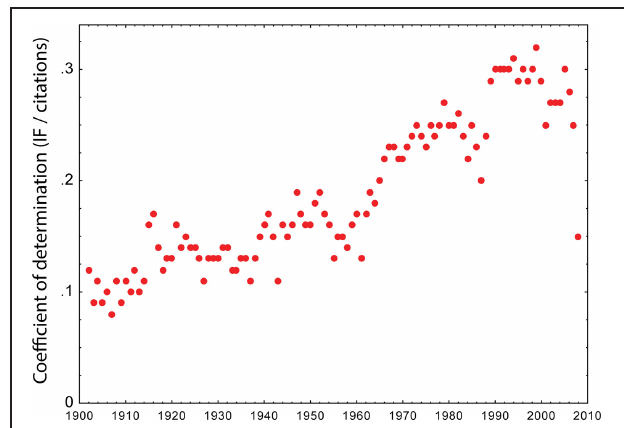
FIGURE 3 | Trends in predicting citations from journal rank. The coefficient of determination (R 2 ) between journal rank (as measured by IF) and the citations accruing over 2 years after publications is plotted as a function of publication year in a sample of almost 30 million publications. Lozano et al. (2012) make the case that one can explain the trends in the predictive value of journal rank by the publication of the IF in the 1960’s (R 2 increase is accelerating) and the widespread adoption of internet searches in the 1990’s (R 2 is dropping). The data support the interpretation that reading habits drive the correlation between journal rank and citations more than any inherent quality of the articles. IFs before the invention of the IF have been retroactively computed for the years before the